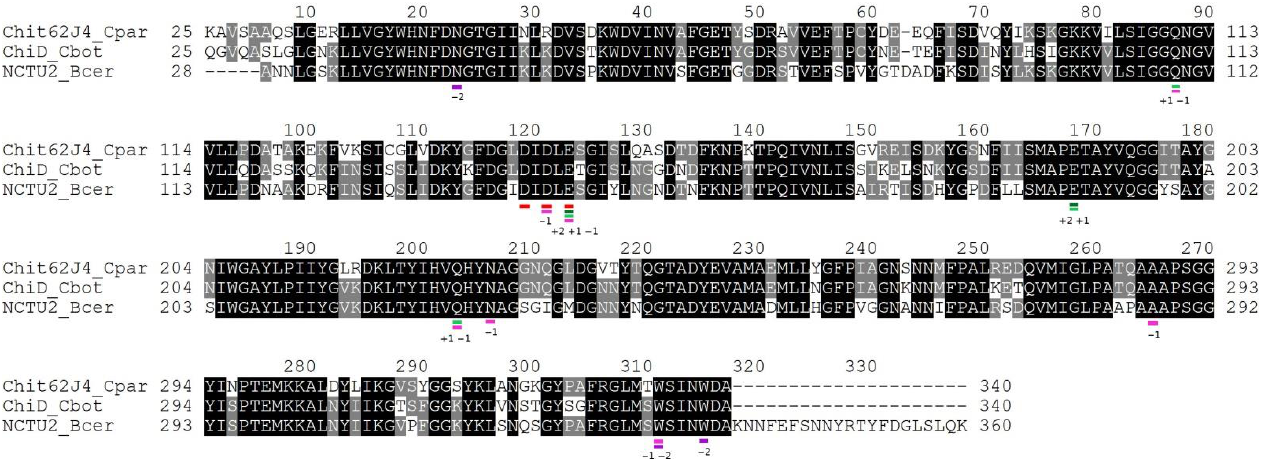
Figure 2. Sequence alignment of Chit62J4 from C. paraputrificum J4, chitinase D from C. botulinum and chitinase ChiNCTU2 from B. cereus . Identities are marked by black background. Expected catalytic residues are marked by a red line; residues forming the − 2 to +2 subsites (according to Hsieh et al. [36]) of the substrate binding site are marked by colored lines and site numbering.